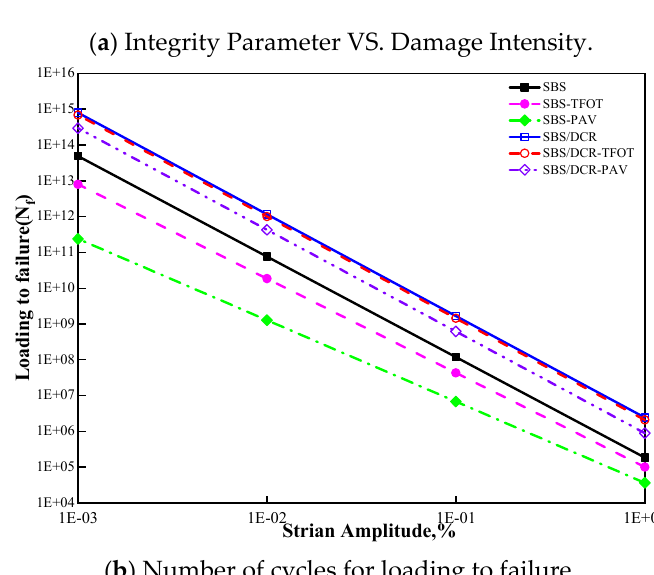
Figure 7. Results Linear Amplitude Scanning Test in Different aging conditions. ( a ): Integrity Parameter VS. Damage Intensity; ( b ): Number of cycles for loading to failure.